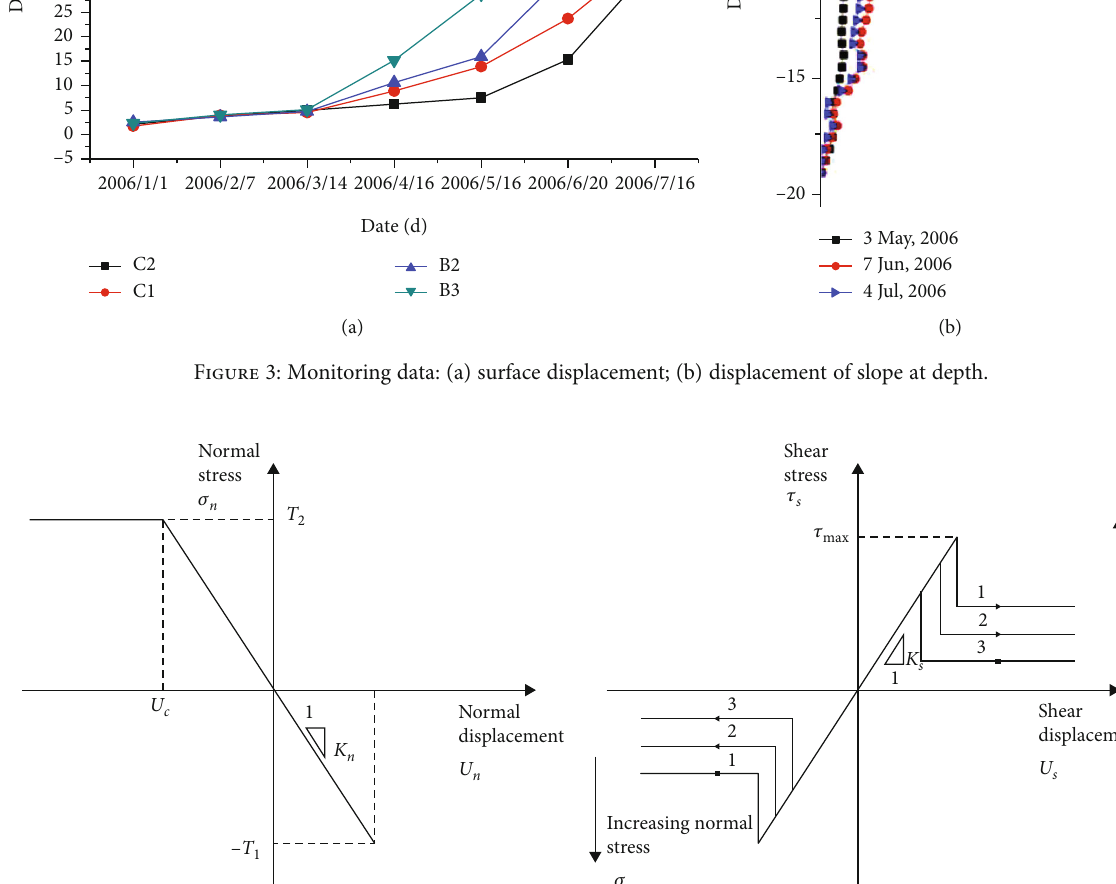
Figure 4: Coulomb slip with residual strength criteria: (a) in normal direction ; (b) in shear